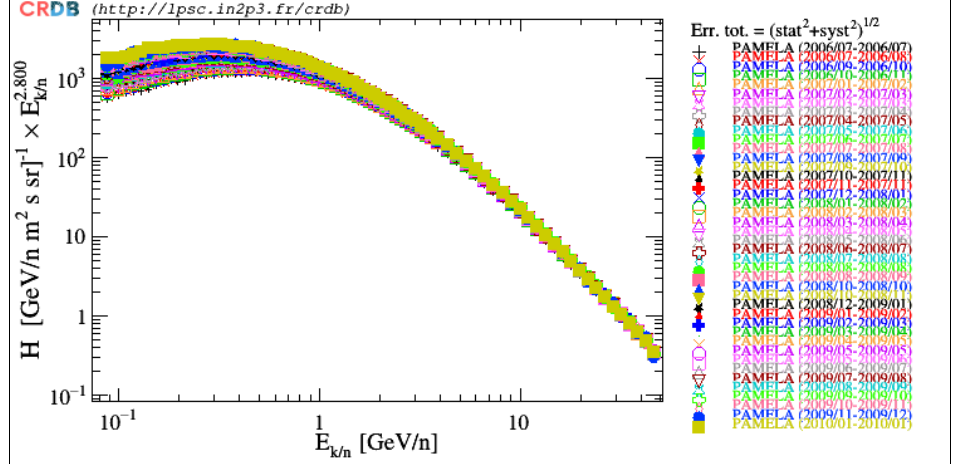
Figure 6. Illustration of the ‘time series only’ option in the query selection criterion on PAMELA data